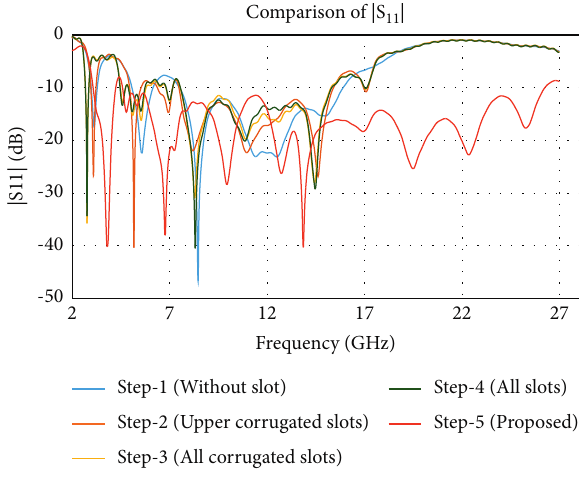
Figure 2: Return loss curve for different evolution stages. Table 1: Geometrical parameters of the proposed tapered slot super wideband vivaldi